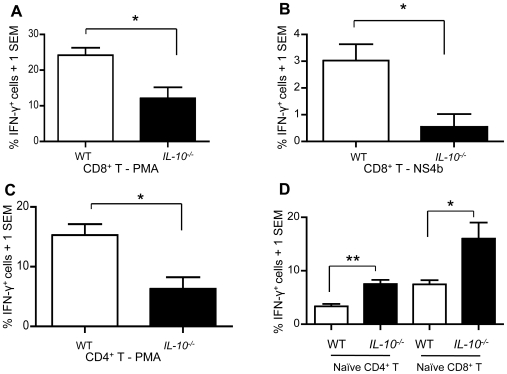
CD4+ and CD8+ T cells deficient in IL-10 produce less IFN-γ.(A–C) IL-10−/− and wild-type (WT) mice were i.p. challenged with WNV (LD50). On day 7, mice were euthanized and splenocytes were isolated and stimulated with PMA or WNV NS4b peptide for 6 hours. Flow cytometry analysis of IFN-γ-producing CD8+ T cells after stimulation with (A) PMA or (B) with WNV NS4b peptide was then carried out. (C), Flow cytometry analysis of IFN-γ producing CD4+ T cells after stimulation with PMA is shown. These data represent two independent experiments (n = 4/group). (D), Splenocytes were isolated from naïve IL-10−/− and WT mice and stimulated with PMA for 6 hours. Flow cytometry analysis of IFN-γ-producing CD4+ and CD8+ T cells is shown (n = 3/group). * p<0.05 and **p<0.01.